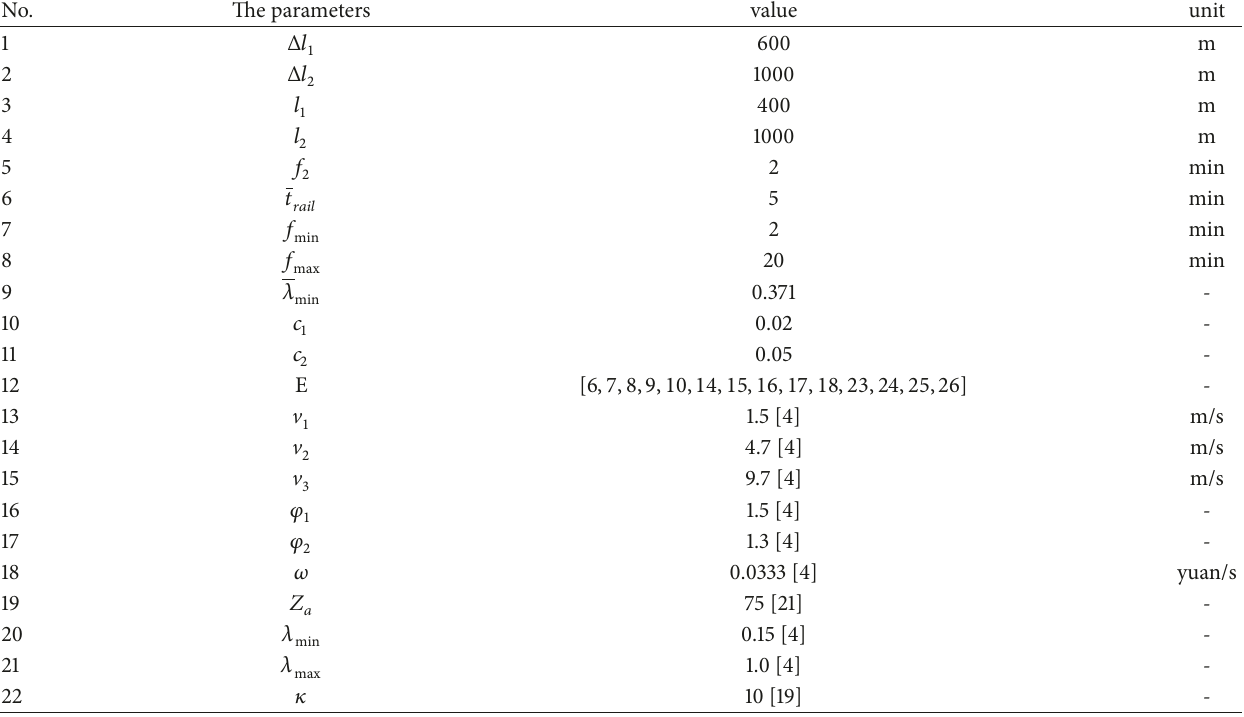
Table 1: The parameter values in the model.